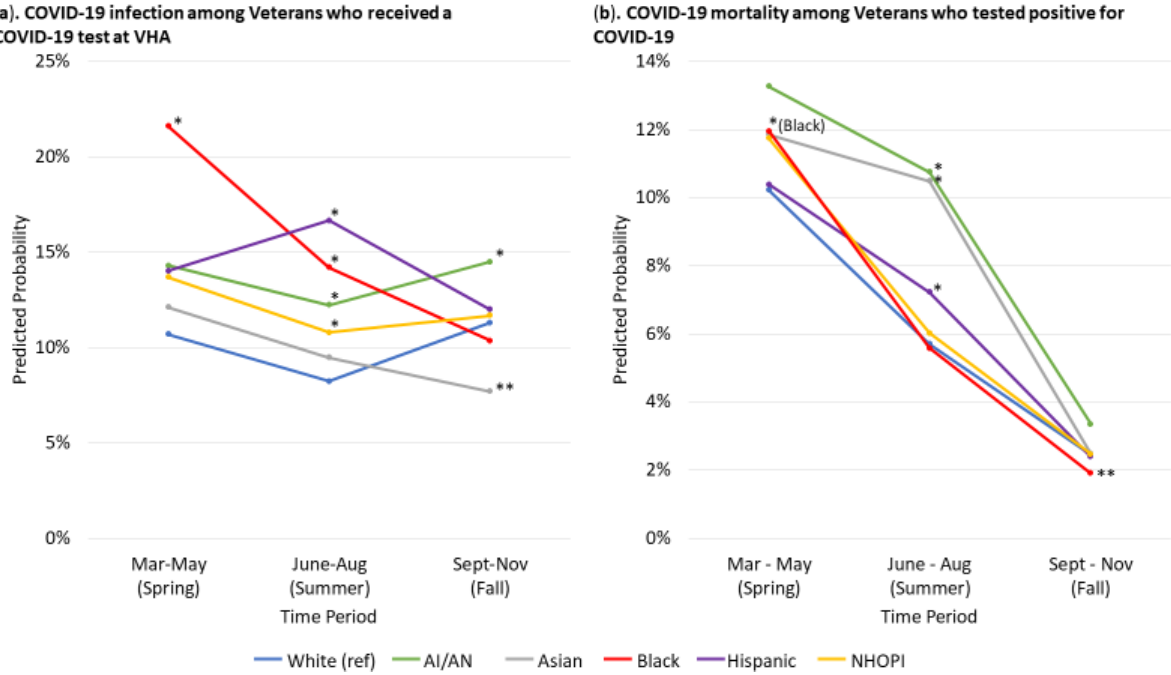
Figure 1. Adjusted predicted probability of COVID-19 infection and mortality by race/ethnicity over time. ( a ) presents the adjusted predicted probability of COVID-19 infection by race/ethnicity over time among Veterans who received a COVID1-9 test at VHA. ( b ) presents the adjusted predicted probability of COVID-19 mortality by race/ethnicity over time among Veterans who tested positive for COVID-19. Note: * denotes statistically significant differences at p < 0.05 that favor the reference group of non-Hispanic White veterans (i.e., disparities); ** denotes statistically significant differences at p < 0.05 that favor the racial/ethnic minority group versus the reference group of non-Hispanic White veterans. Models adjusted for age, sex, and prior diagnoses of CDC-identified risk factors (chronic kidney disease stage-5/end-stage renal disease; chronic pulmonary disease; diabetes; heart disease; immunocompromised state; liver disease; obesity; and asthma). Models included multi-race individuals and those with missing or unknown race/ethnicity, but results are not shown. Table 4. Adjusted odds ratios of COVID-19 infection among veterans who were evaluated for COVID-19 at VHA and odds ratios of mortality among veterans who tested positive for COVID-19 by race/ethnicity over time.